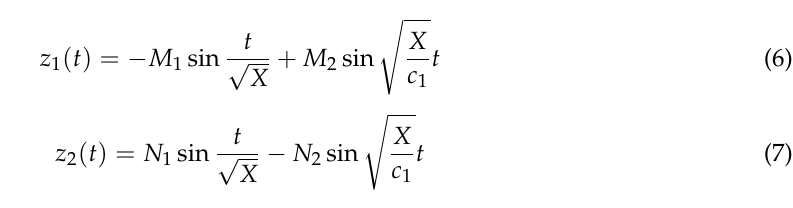
Figure 9. Effect of head loss on the highest water levels in surge tanks [62].